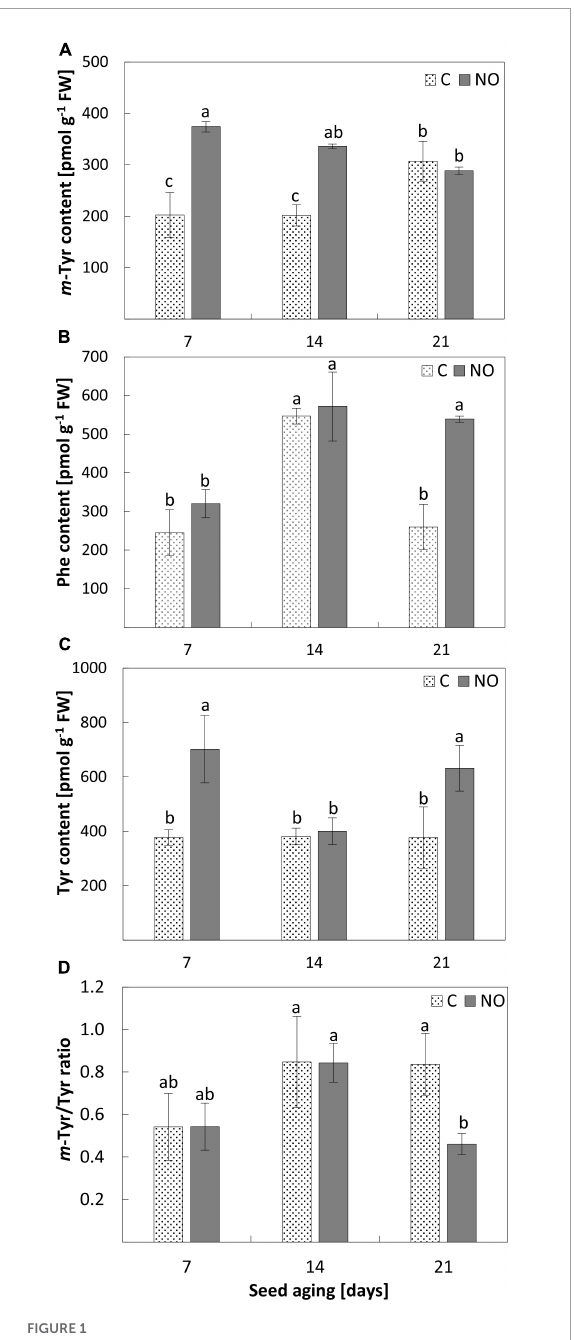
FIGURE1 The content of m -Tyr (A) , Phe (B) , Tyr (C) , and the m -Tyr/Tyr ratio (D) in the axes of apple seeds subjected to accelerated aging for 7, 14, and 21 days (C) and in the axes of apple embryos fumigated with NO after seeds accelerated aging (NO). Values are average ± SD of 3 independent repetitions. Letters indicate the significant differences determined by Duncan’s test ( P < 0.05).